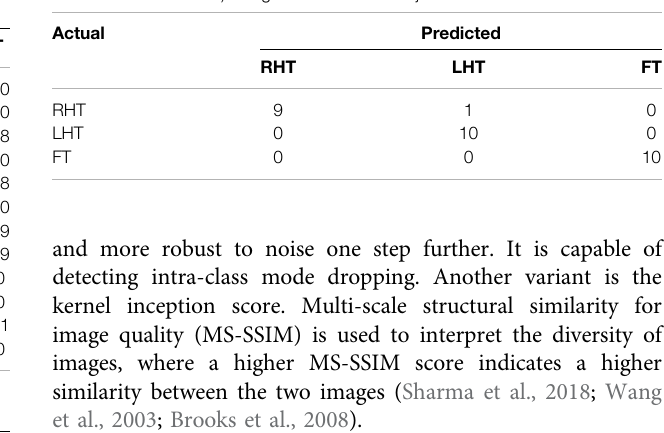
TABLE 4 | The Confusion Matrix obtained by CNN model using test data from subject 1 for original data set. Actual